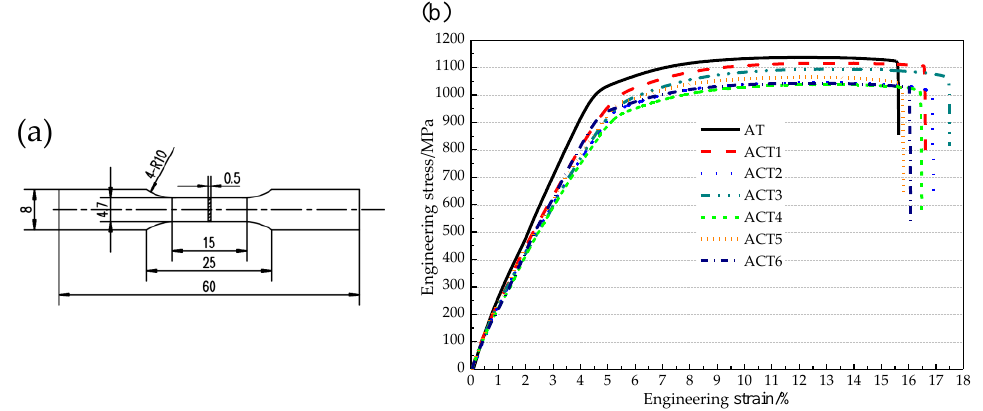
Figure 2. Tensile sample and stress and strain curves under different treatment ( a ) the tensile sample; and ( b ) stress-strain curves under different treatment. (unit: mm)